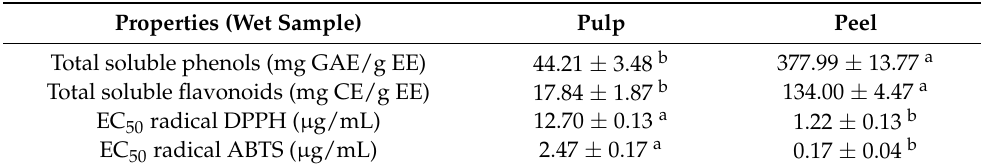
Results are expressed as the mean ± standard deviation of the analysis performed in triplicate. Different letters in the same row are significantly different ( p < 0.05). GAE: gallic acid equivalents; CE: catechin equivalents; EE: ethanolic extract.